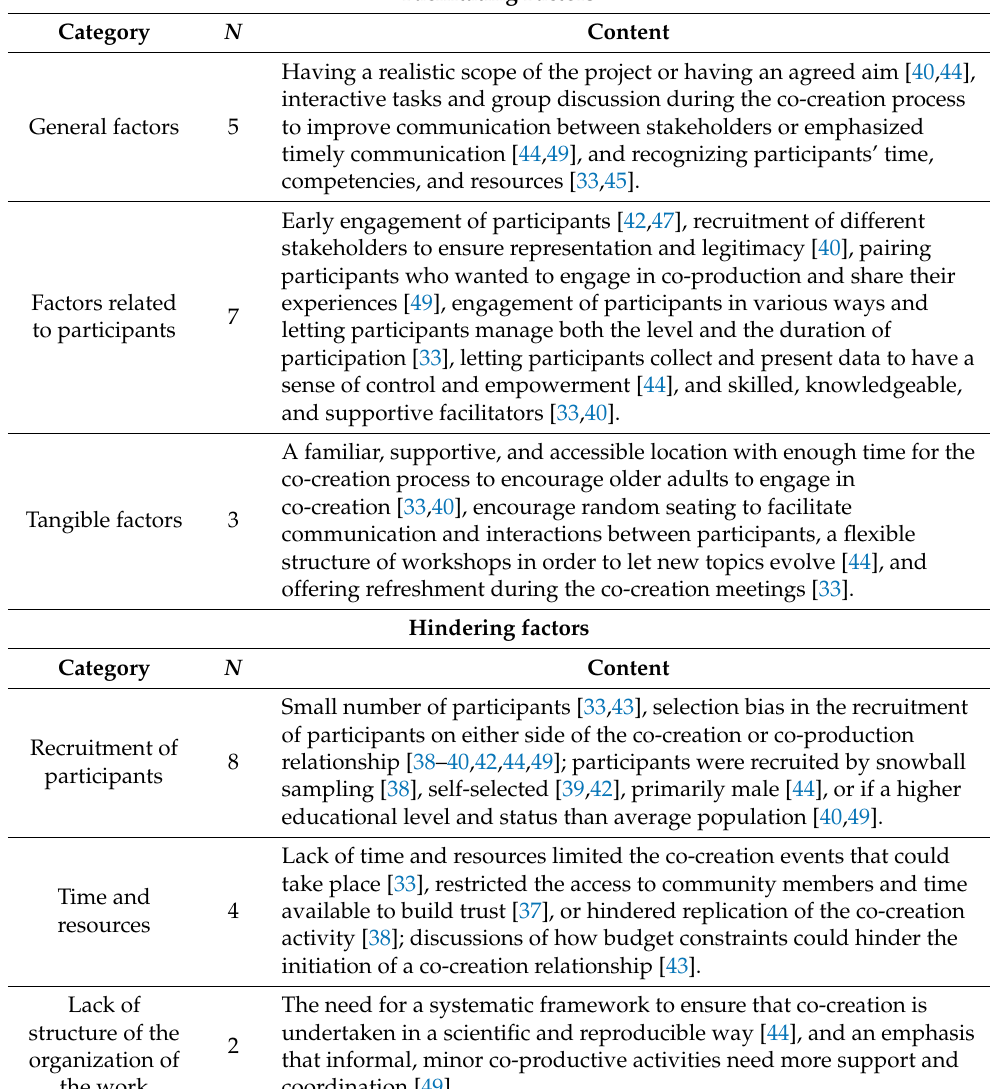
Table 2. Influential factors for co-creation and